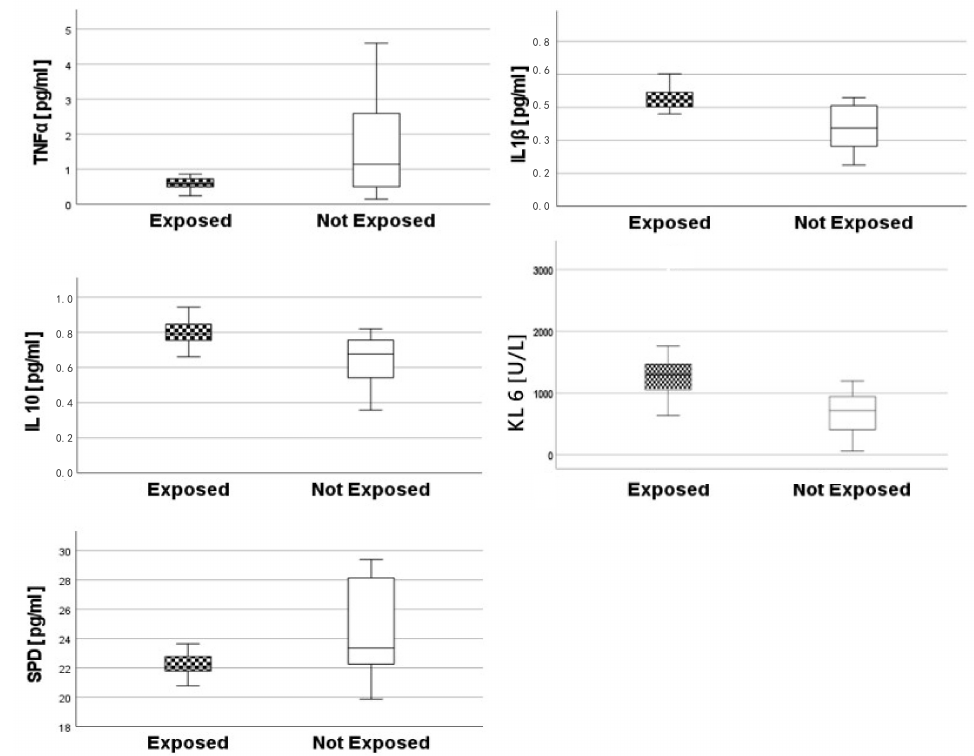
Figure 4. Descriptive statistics of biomarkers determined in EBC (Mann–Whitney test). Pro- inflammatory cytokines TNF- α , IL-1 β and of IL-10 were significantly different between groups ( p = 0.003, p < 0.001, p < 0.001, respectively). KL-6 glycoprotein values were significantly higher in exposed workers than in not exposed ( p = 0.003), whereas SP-D values were significantly lower in exposed workers than in not exposed (p =